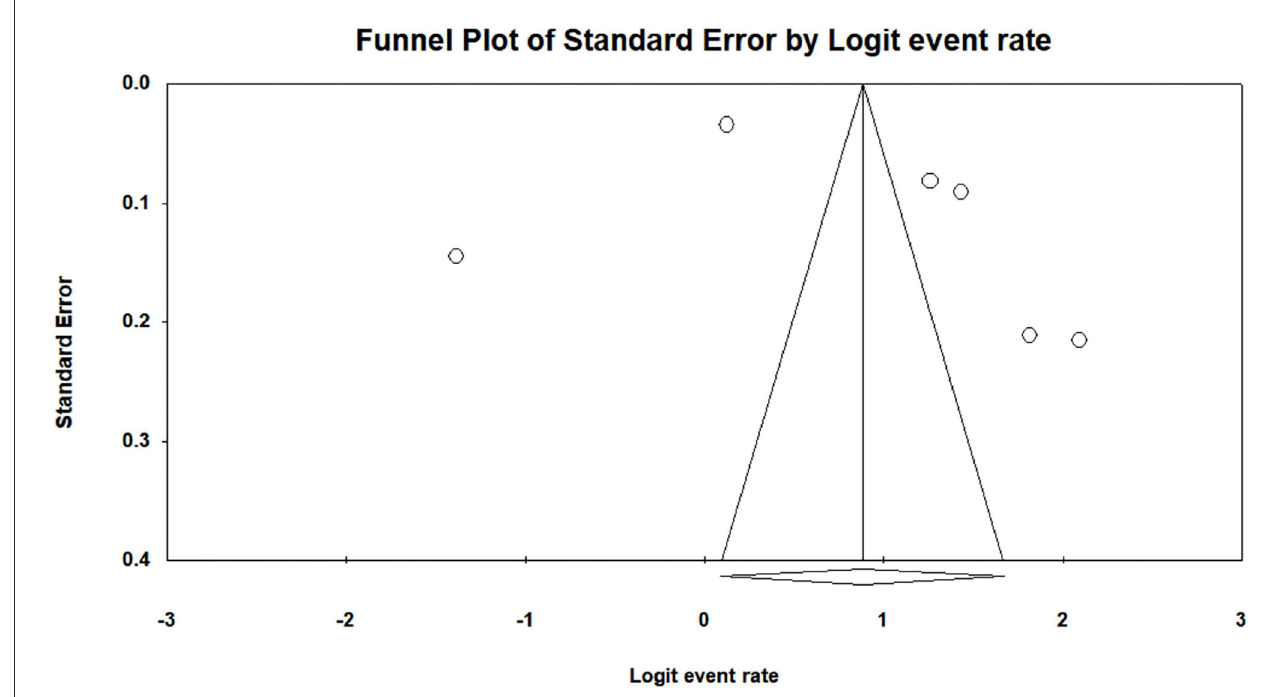
FIGURE4 A funnel plot assessing publication bias of satisfaction with online education among parents before and after the COVID-19 outbreak.